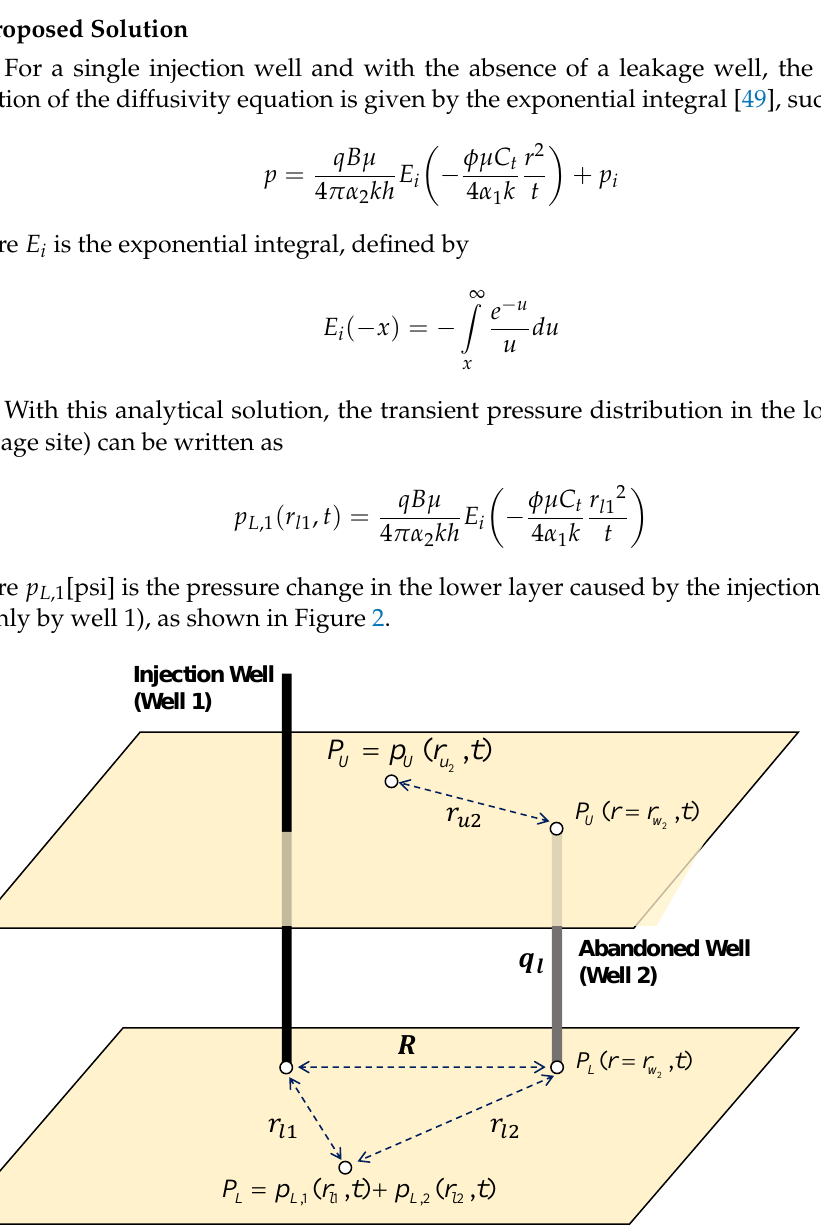
Figure 2. Illustration of the lower and upper layers with the variables used in the solution method, where the abandoned well is located at distance R from the injection